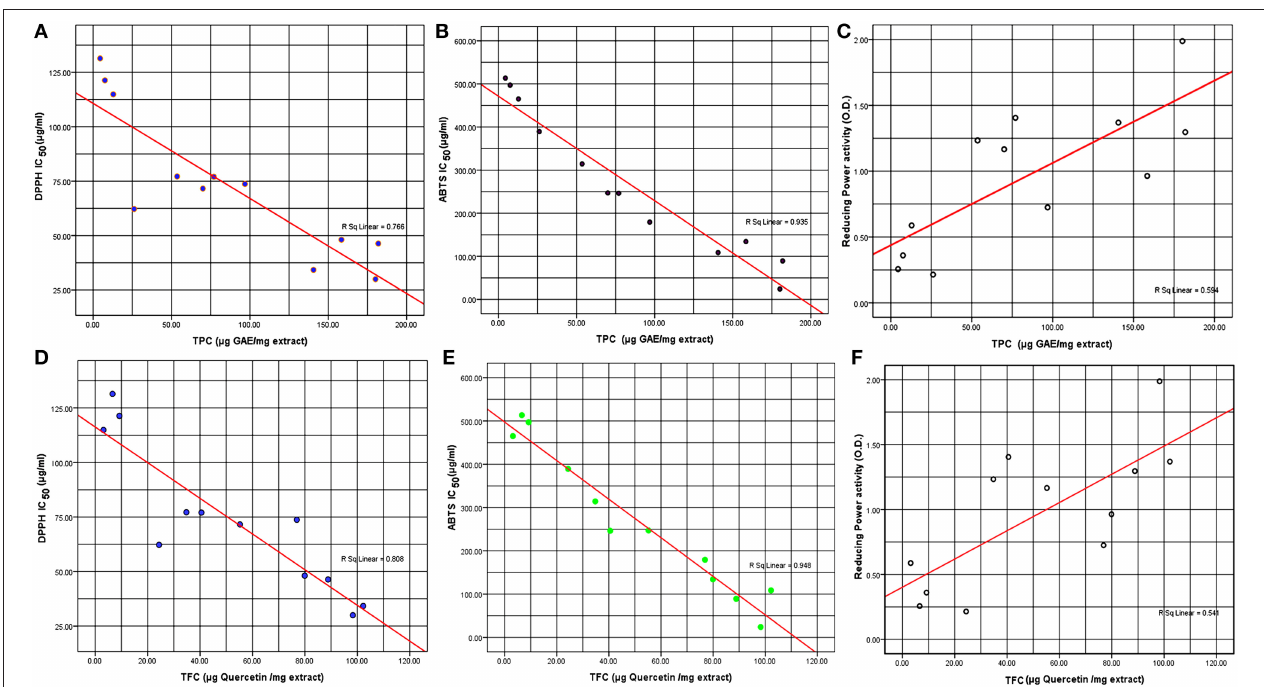
FIGURE 1 | Correlation of (A) TPC and DPPH free radical scavenging activity IC50 DPPH ( µ g, DPPH/mL), (B) TPC and ABTS ( µ g, ABTS/mL), (C) TPC and reducing power activity, (D) TFC and DPPH free radical scavenging activity IC50 DPPH ( µ g, DPPH/mL), (E) TFC and ABTS ( µ g, ABTS/mL), (F) TFC and reducing power